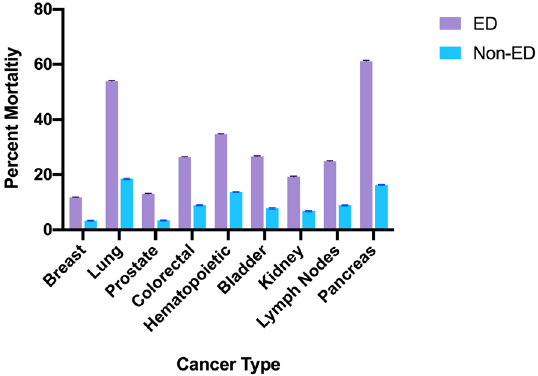
Figure 1. Bar graph comparing mortality among nine cancers. Bar graph comparing mortality percentages from cases compared to controls for the top 9 most common cancers, over 5-year study period, error bars representing 95% CI.